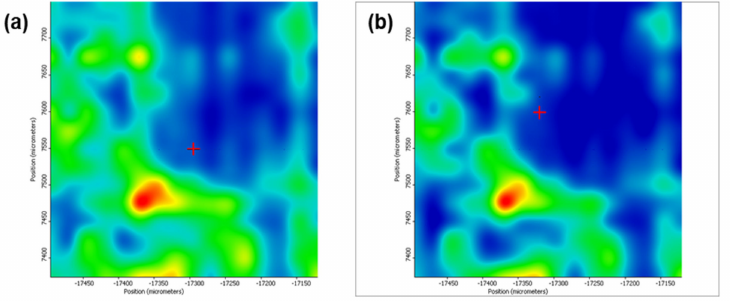
Figure 5. Second derivate IR mappings of Fe 3 O 4 @ β -CD drop-cast: surface intensity distribution of ( a ) C-H and CH 2 stretching vibrations at 2930 cm − 1 and ( b ) C-O bond stretching vibrations at 1029 cm − 1